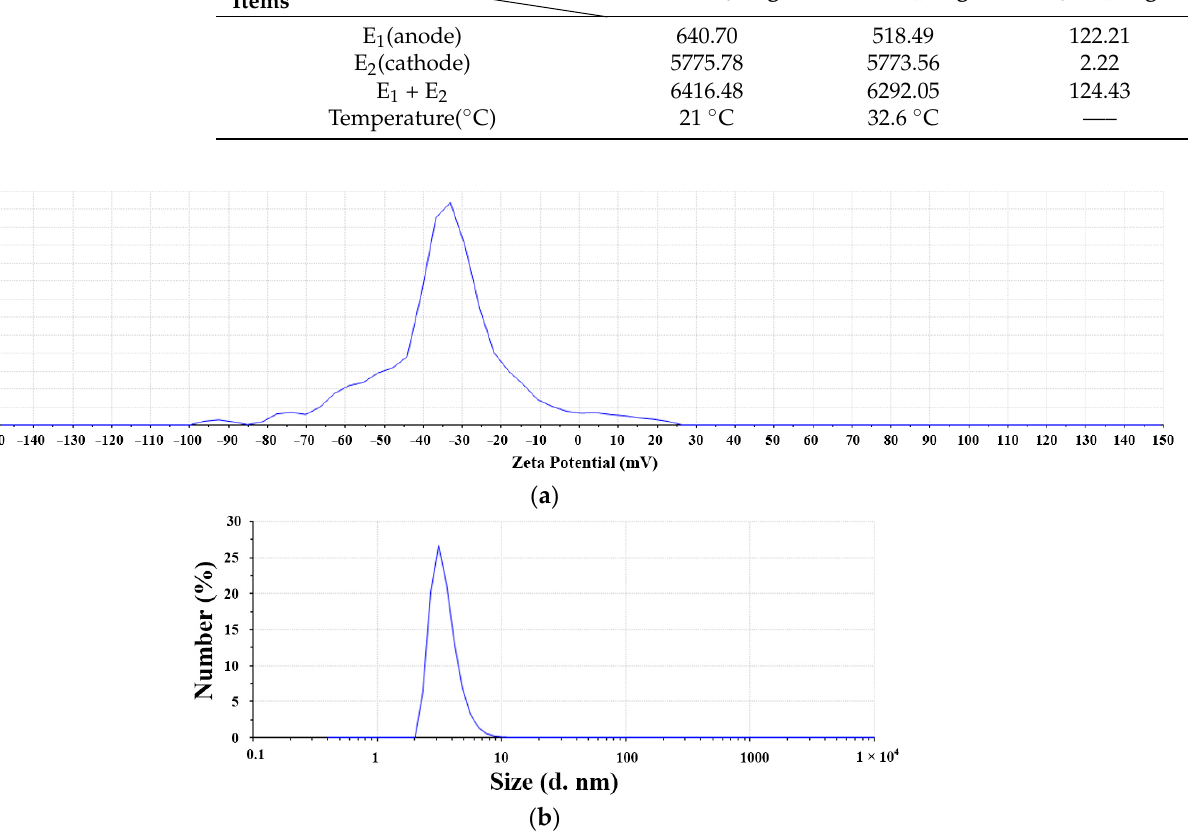
Figure 9. Characteristics of nanosilver colloid prepared using EDM: ( a ) zeta potential distribution; ( b ) number PSD. Table 5. Parameter settings of the EDM.